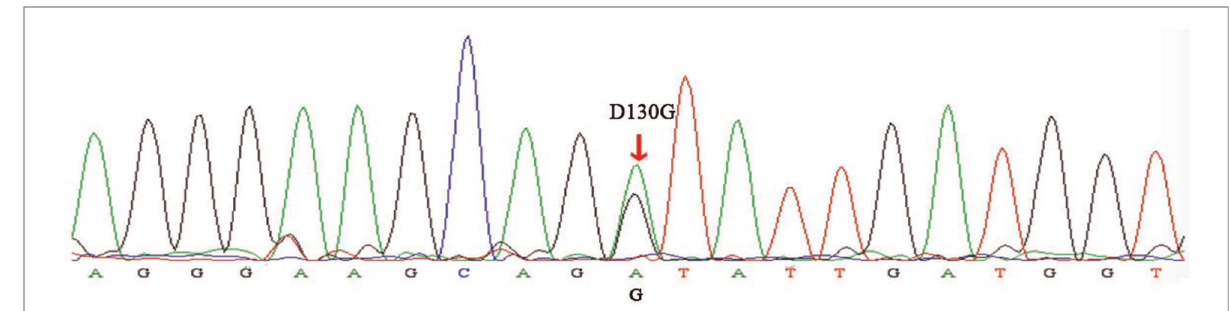
FIGURE 2 Sanger sequencing electropherogram. The variant (c.389A>G) demonstrated the replacement of a conserved aspartic acid residue at position 130 with glycine (p.D130G) in the CALM2 gene (red arrow).